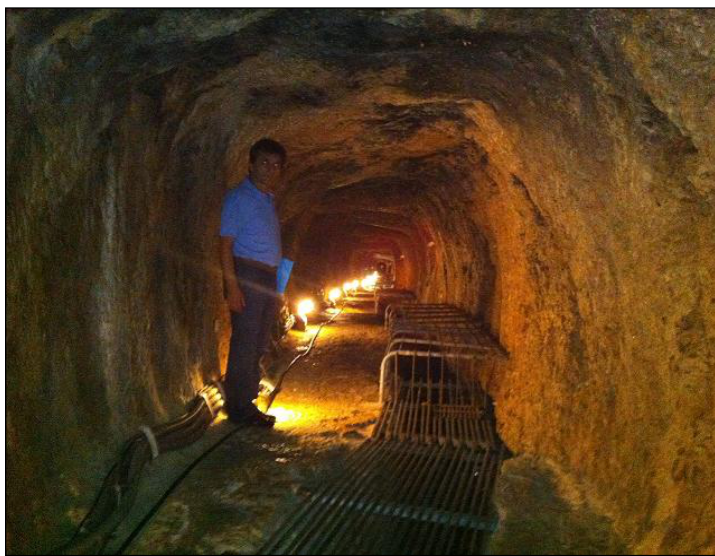
Figure 7. A view of the tunnel of Eupalinos with the aqueduct channel on the right hand side of the picture (below the